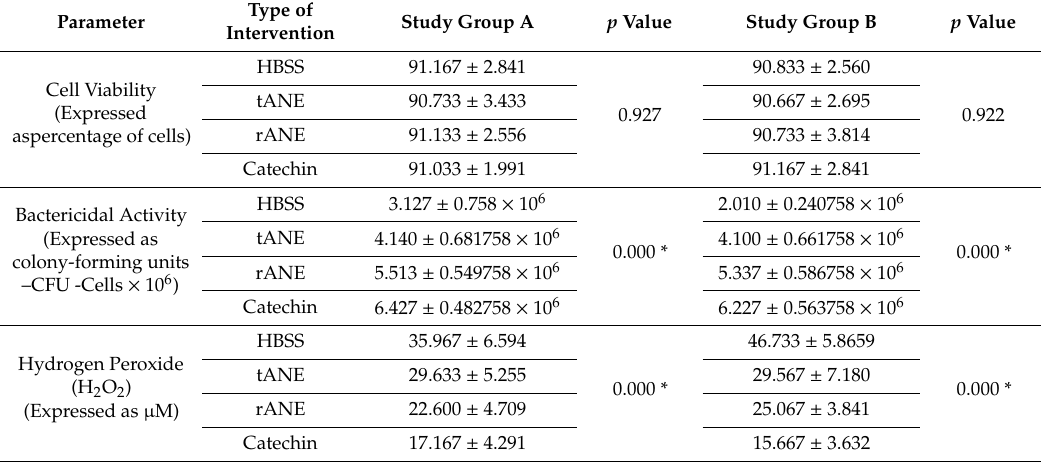
Table 2. Intragroup comparative analysis of microbiological (cell viability and bactericidal activity) and biochemical (hydrogen peroxide) parameters.